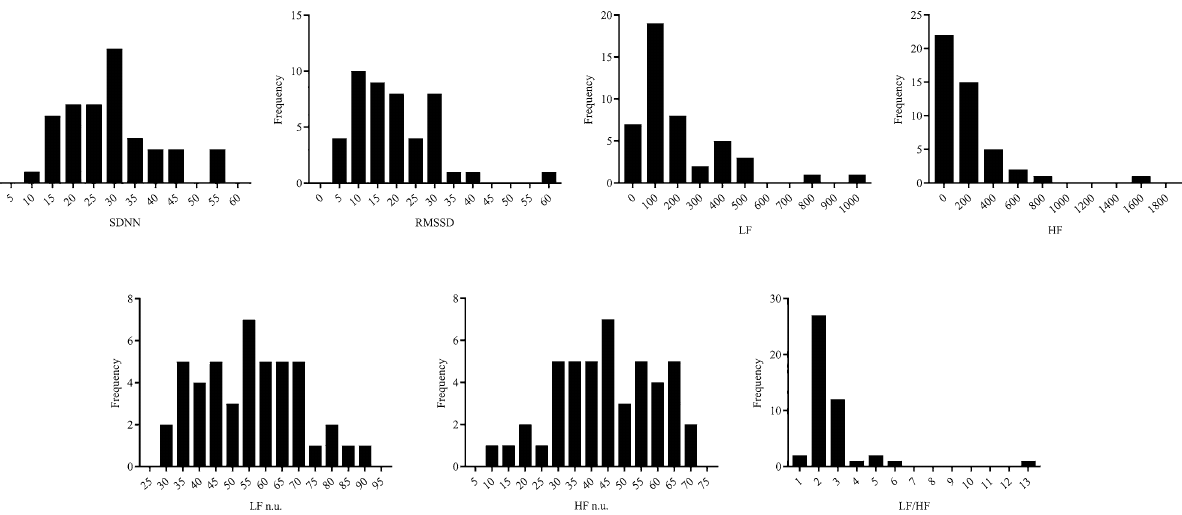
Figure 1. Histograms of HRV parameters (SDNN, RMSSD, LF, HF, LF n.u., HF n.u., and LF/HF).